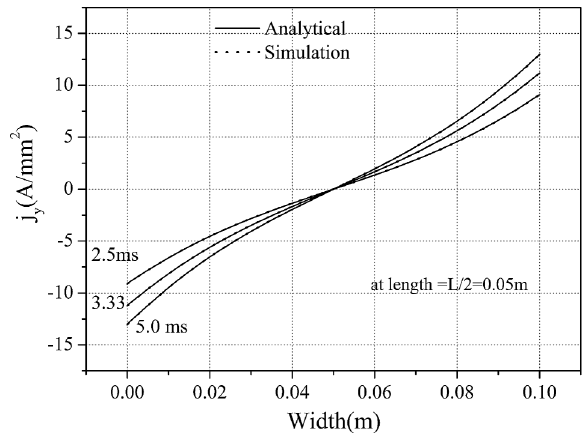
FIG. 6. Variation of the eddy current density, j of dimension ð 0 : 1 ; 0 : 1 ; 0 : 002 Þ m 3 for 50 Hz frequency and 0.923 21 T peak field at different times obtained from two different methods.